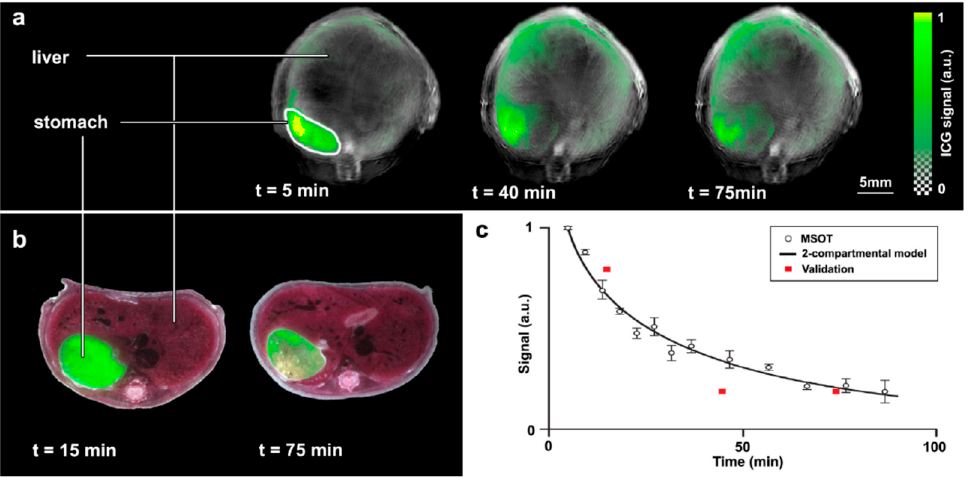
Figure 7. Gastric motility imaging using oral delivery of ICG. ( a ) ICG distribution after administration, ( b ) Ex vivo fluorescence verification in animals sacrificed after ICG dosing and ( c ) optoacoustic signal intensity over time compared with ex vivo fluorescence verification (red squares). Figure from [73] reproduced with permission from the publisher.